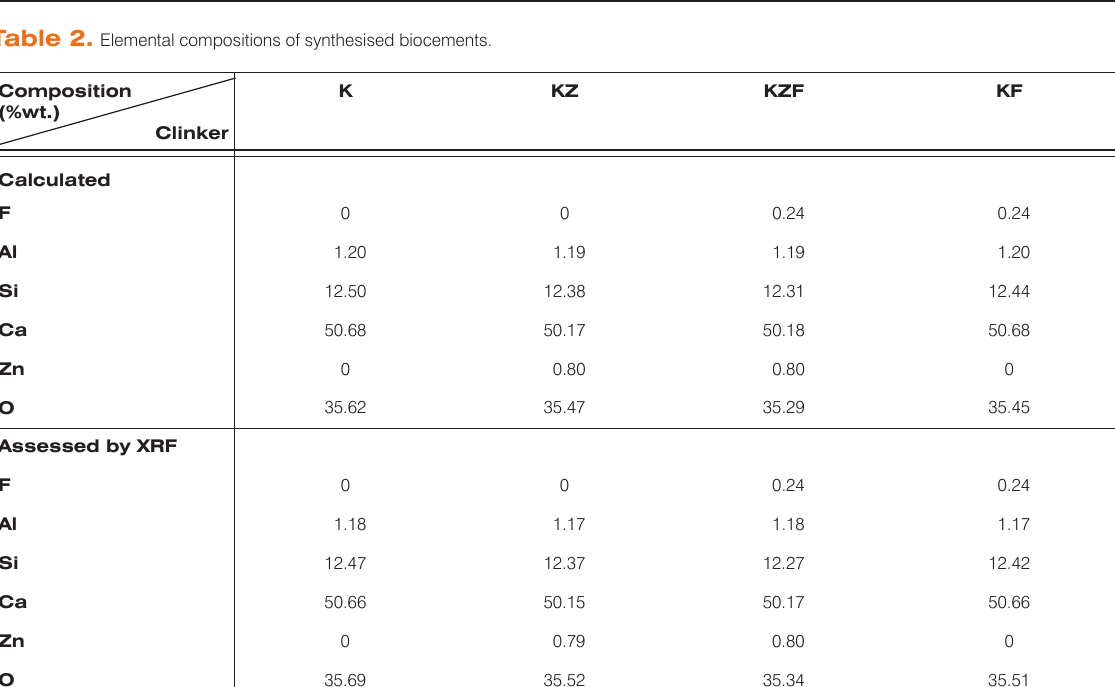
Table 2. Elemental compositions of synthesised biocements. Composition (%wt.)